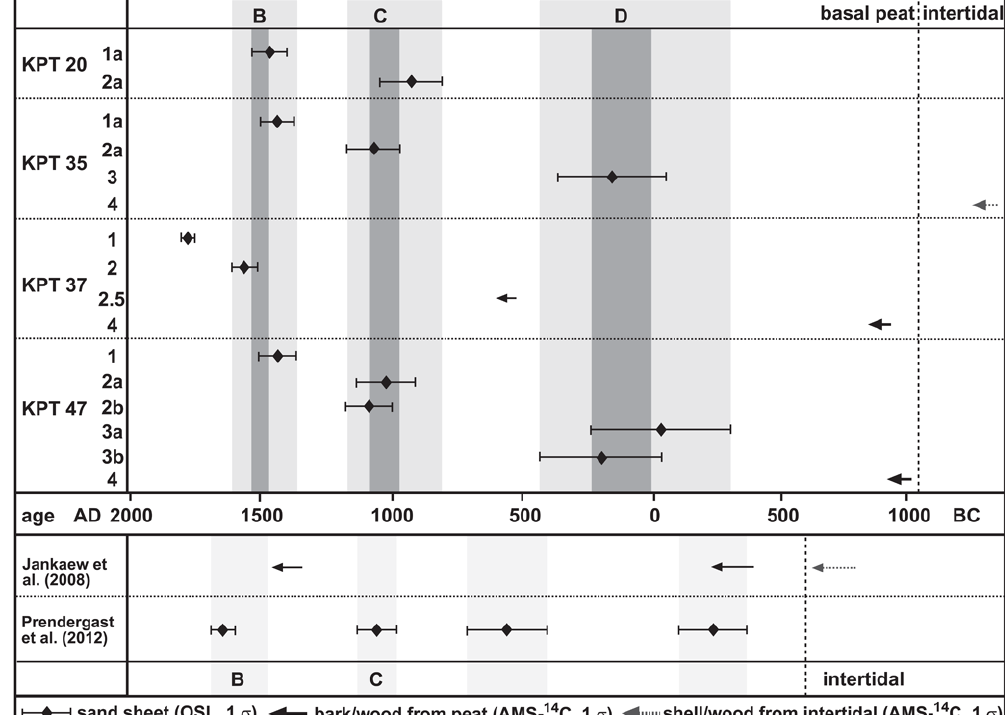
Fig. 9. Age plot of all dated profiles in swale VI (upper part) in relation to the results of other studies (lower part). The comparison of the four different profiles of swale VI shows that the layer ages cluster within intervals at 400–660 (B), 820–1230 (C) and 1600–2300 (D) years (light grey areas). The dark grey areas indicate the weighted mean of all ages inside a cluster. Each cluster is related to one palaeotsunami event (B, C,